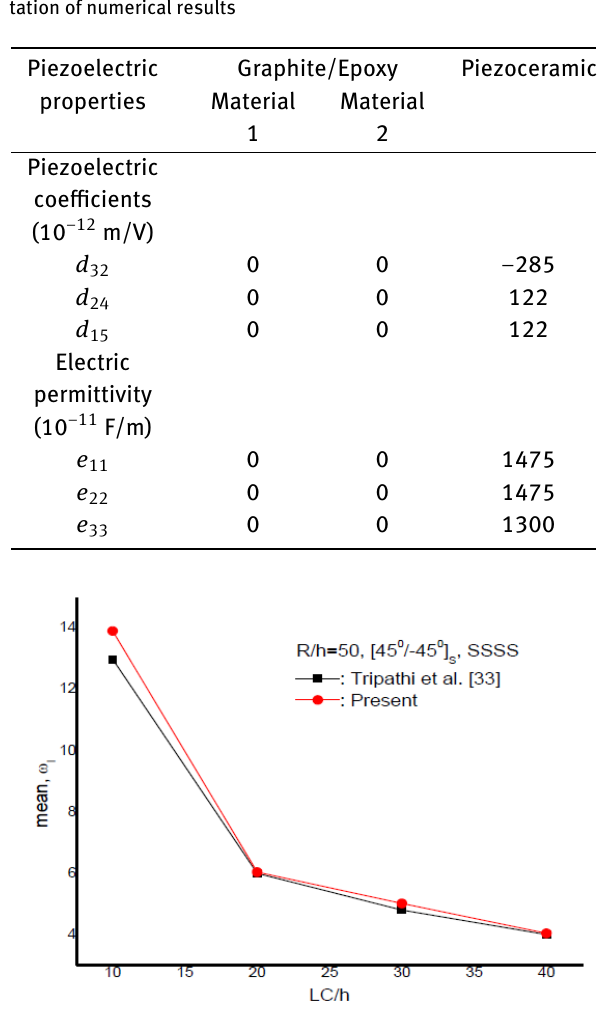
Table 2: The following piezoelectric properties are used for compu-